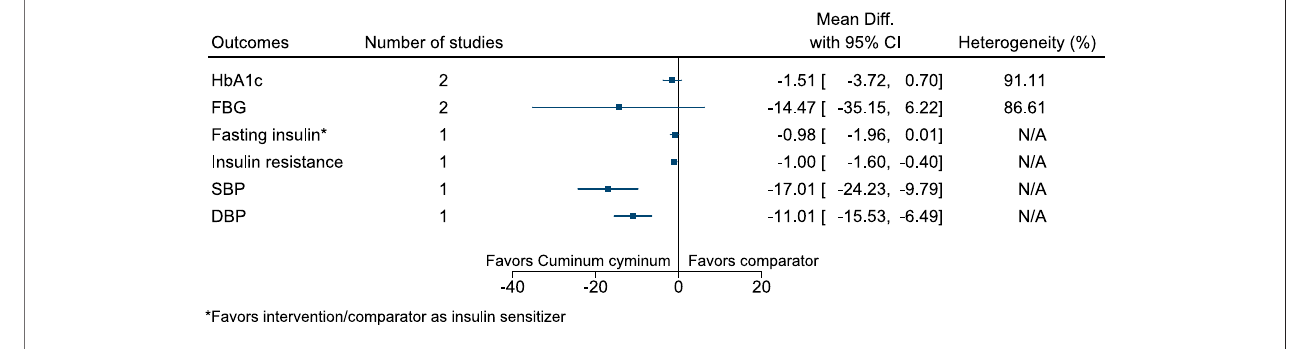
FIGURE 14 | Cuminum cyminum — Summary forest plot.